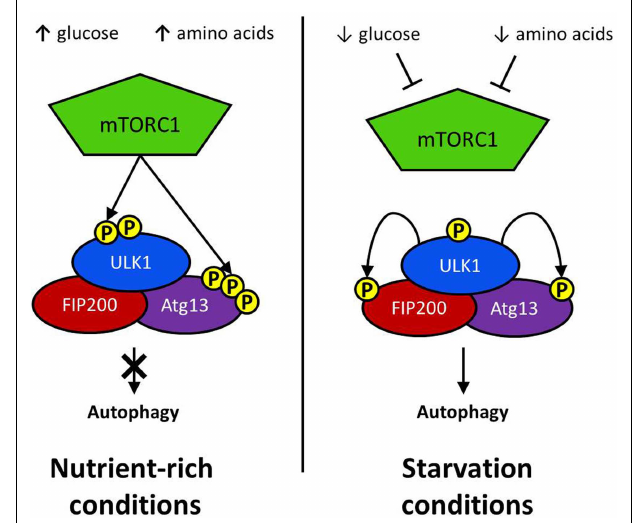
FIGURE 2 | Initiation via ULK1 complex: the regulatory complex mTORC1 represses autophagy activation in nutrient rich conditions. mTORC1 phosphorylates a serine residue on ULK1 to prevent it interacting with positive regulators of autophagy induction. Atg13 activation is similarly repressed by mTORC1-mediated phosphorylation. Glucose or amino acid starvation results in the repression of mTOR activation. Consequently, ULK1 phosphorylates both FIP200 and Atg13, resulting in the activation of downstream autophagy effector proteins.